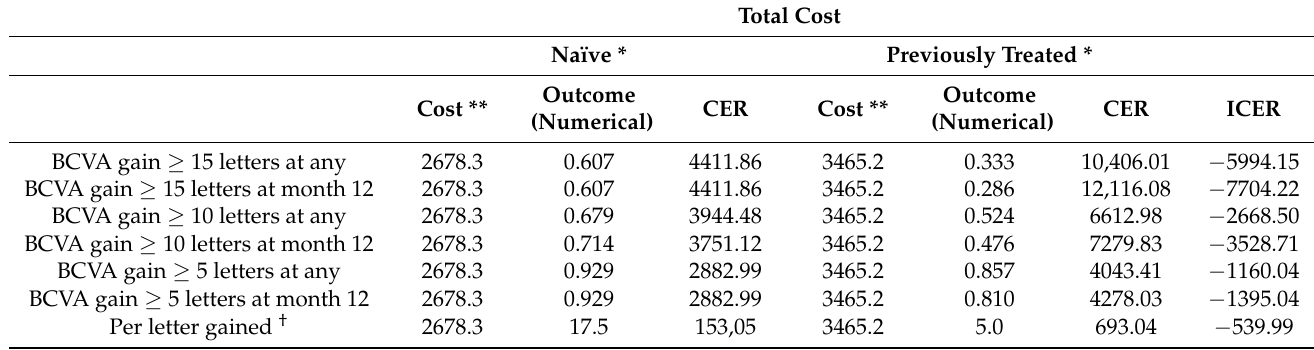
Table 4. Cost-effectiveness ratio (CER) and incremental cost-effectiveness ratio (ICER) analysis considering the total direct costs according to the Andalusian Public Health